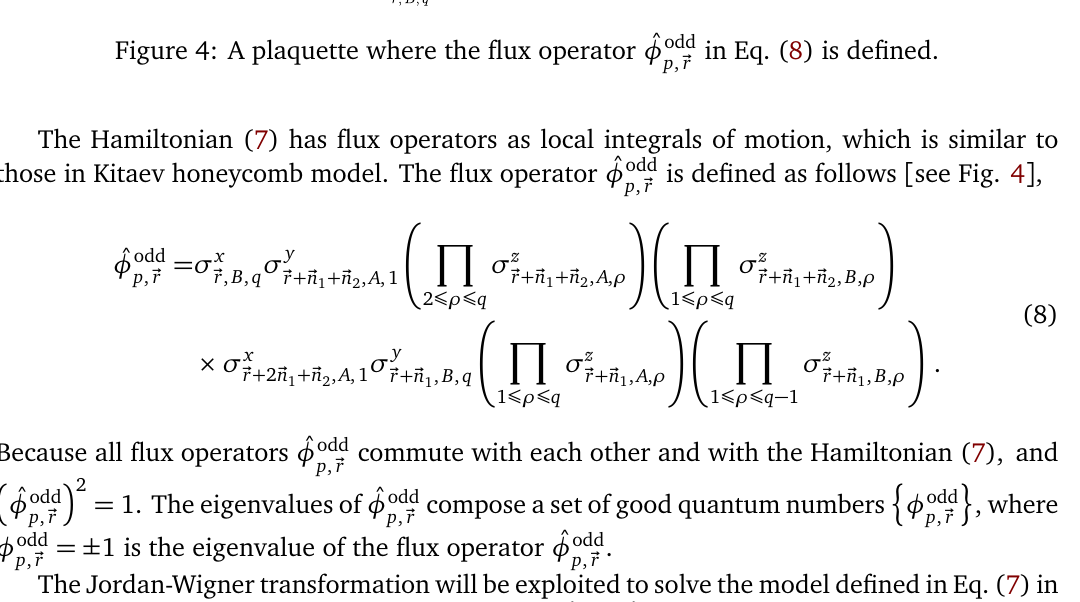
Figure 4: A plaquette where the flux operator ˆ φ odd